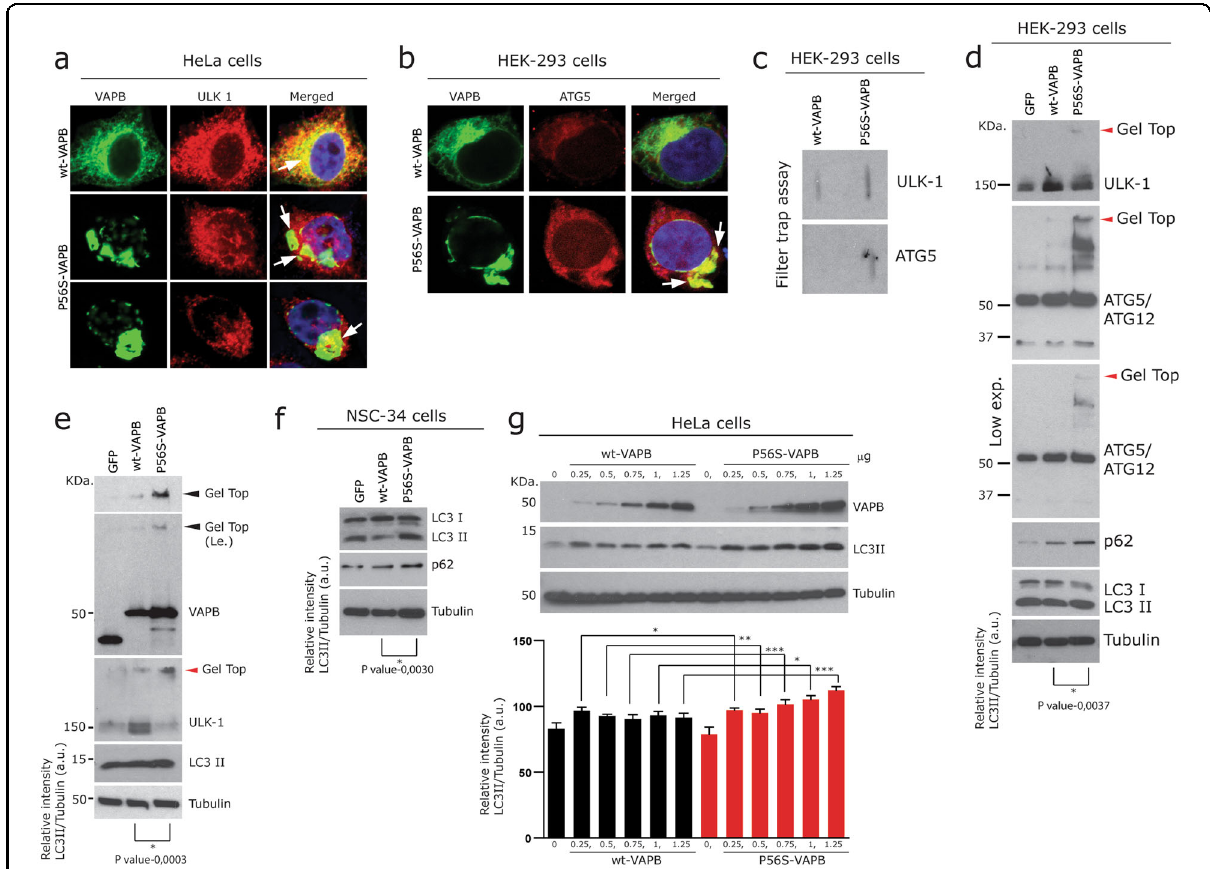
Fig. 3 P56S-VAPB alters early steps of autophagy. a Co-labelling of wt-VAPB and P56S-VAPB transfected HeLa cells with ULK1 showing co- localisation with wt-VAPB. Note the reduction as well as the sequestration of ULK1 (arrows; merged middle and lower images) with P56S-VAPB aggregates. Scale bar: 10 µm. b Sequestration of ATG5-ATG12 (arrows) with P56S-VAPB aggregates in HEK-293 cells Scale bar: 10 µm. c Filter trap assay of the above transfected cells, showing SDS resistant aggregates of ULK1 and ATG5-ATG12 in P56S-VAPB expressing cells. d , e Immunoblot analysis showing gel top aggregation (red arrowheads) as well as reduced soluble levels of ULK1 together with increased levels of LC3-II in P56S-VAPB overexpressing HEK-293 cells ( d ) and in HeLa cells ( e ). Note the gel top aggregation (red arrowheads) of ATG5-ATG12 complex in P56S-VAPB overexpressing cells as well as increased levels of ULK1 in wt-VAPB overexpressing cells. Unpaired Student ’ s t test for comparison between two sample groups Values were expressed as mean ± standard error of mean (SEM) from three independent experiments. The asterisks denote signi fi cant differences (* p < 0.05, *** p < 0.001). f Immunoblot analysis of NSC-34 cells showing increased levels of LC3-II and p62 in P56S-VAPB expressing NSC- 34 motor neuron-like cells. Unpaired Student ’ s t test for comparison between two sample groups Values were expressed as mean ± standard error of mean (SEM) from three independent experiments. The asterisks denote signi fi cant differences (* p < 0.05). g Immunoblot analysis (quanti fi cation below) showing concentration dependent increased levels of LC3-II and p62 in P56S-VAPB overexpressing cells compared to the wt-VAPB expressing HeLa cells. Graph pad prism, One-way ANOVA, values were expressed as mean ± standard error of mean (SEM) from three independent experiments. The asterisks denote signi fi cant differences (* p < 0.05, *** p <